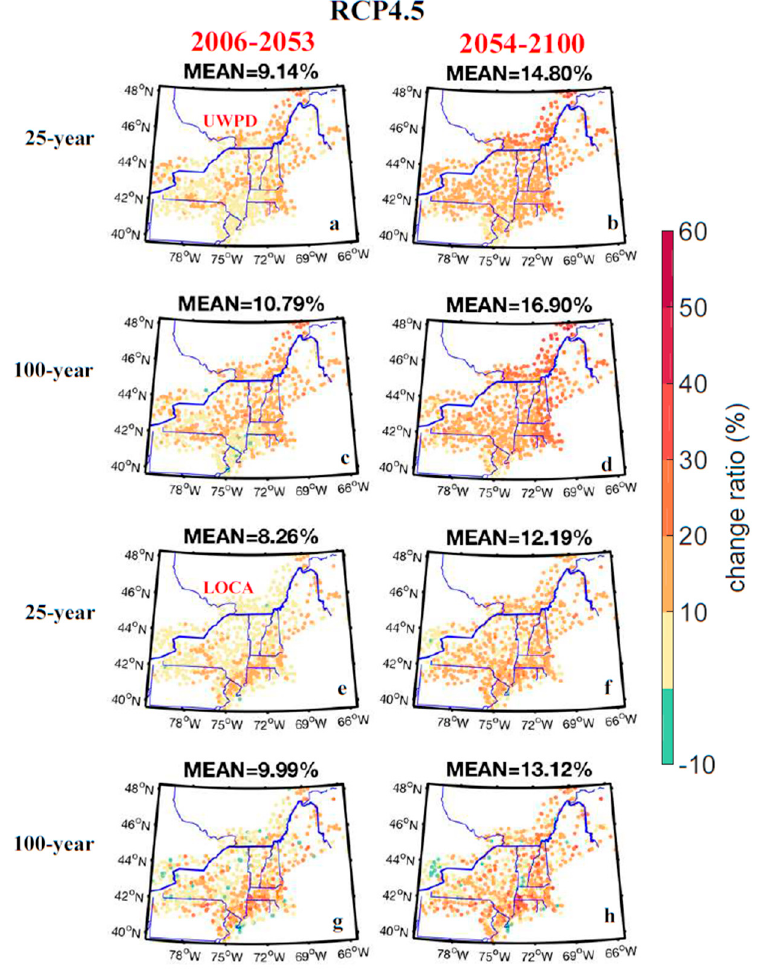
Figure 8. Relative PF difference ratios defined as (PF_future − PF_historical)/PF_historical for a 25-year return period ( a , b , e , f ) and a 100-year return period ( c , d , g , h ) under the RCP4.5 emission scenario.